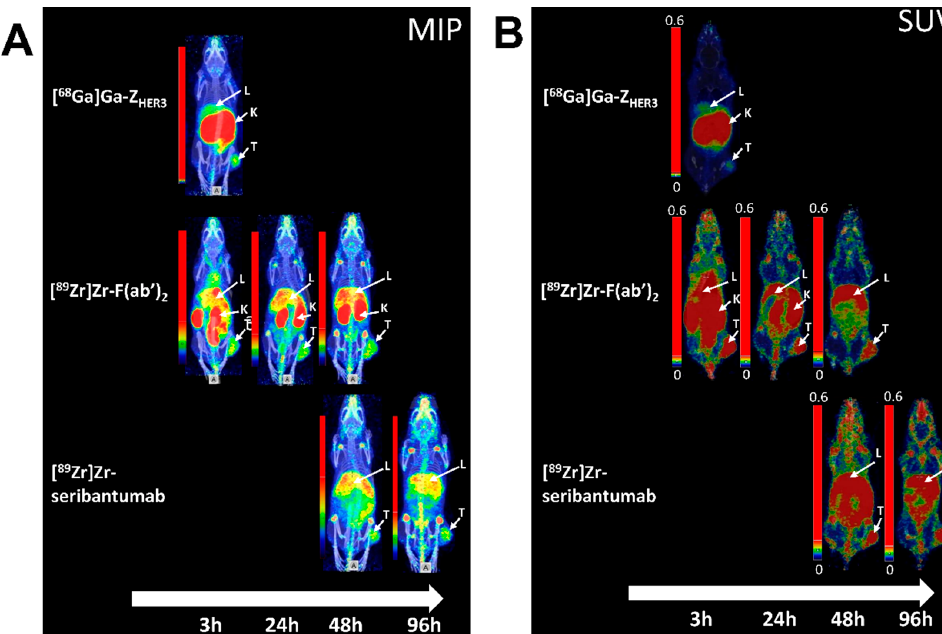
Figure 7. nanoPET/CT images: ( A ) MIP images; ( B ) SUV images of coronal slices. For imaging mice were injected with 1.18 MBq (27 µg) [ 89 Zr]Zr-DFO-seribantumab-F(ab’) 2 , 1.38 MBq (35 µg) [ 89 Zr]Zr-DFO-seribantumab, or 7.05 MBq (2 µg) [ 68 Ga]Ga-Z HER3 . White arrows indicate tumor (T), kidneys (K), and liver (L). [ 89 Zr]Zr-DFO-seribantumab-F(ab’) 2 , [ 89 Zr]Zr-DFO-seribantumab, and [ 68 Ga]Ga-Z HER3